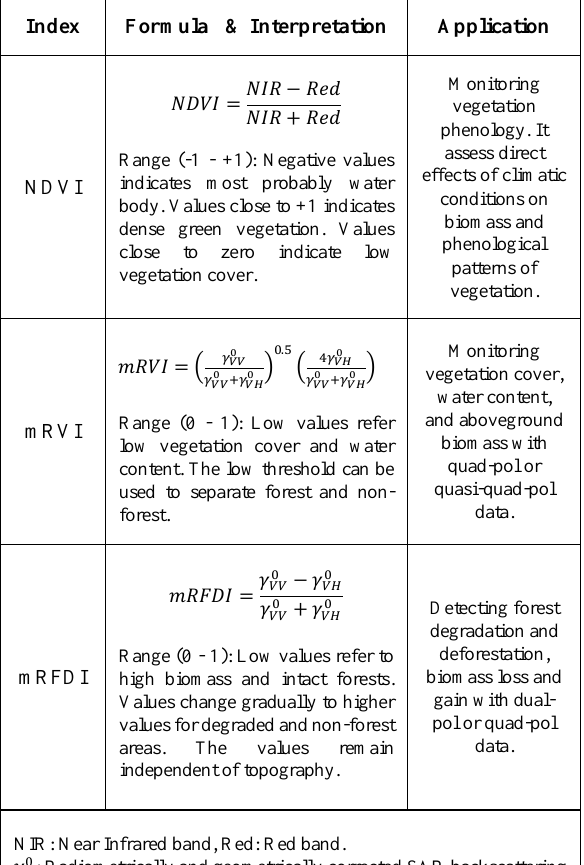
Table 2. Optical - SAR vegetation indices